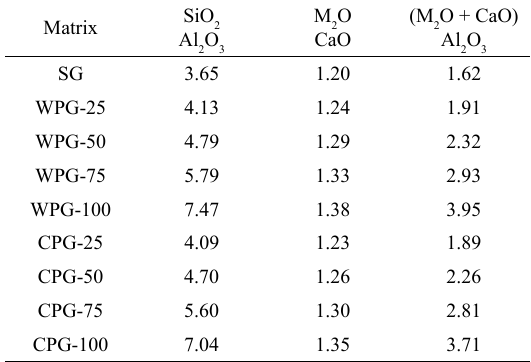
Table 1. Molar ratios of the synthesized geopolymers, where M = Na and K.